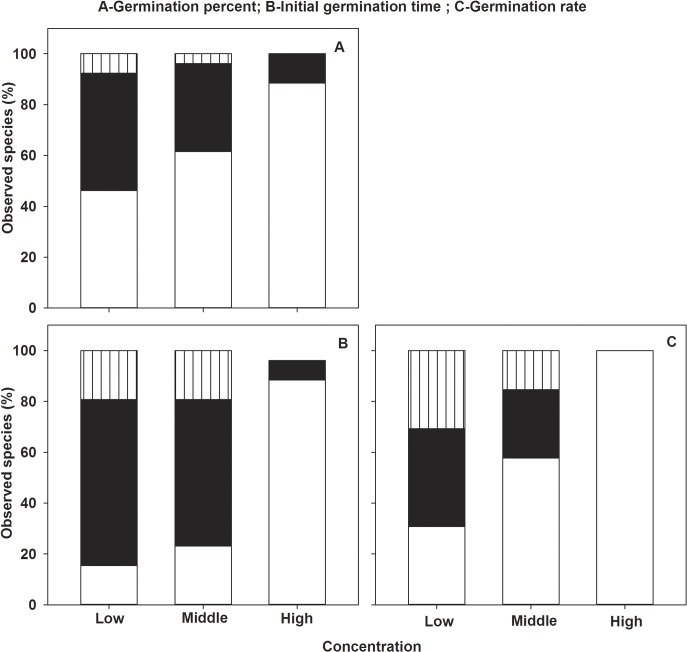
The three different allelopathic effects of Mikania on seed germination percent (A), initial germination time (B) and germination rate (C) of the 26 target species in low, middle and high concentrations of leaf aqueous extract; negative effect (white), neutral effect (black) and stimulated effect (batched).